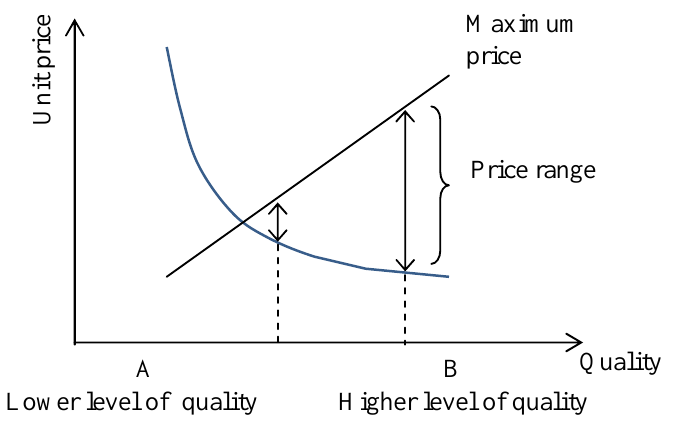
Figure 2 – The effect of pricing (Freiesleben,